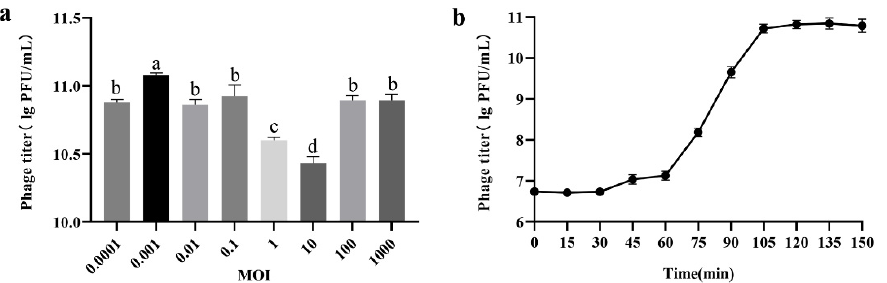
Figure 2. Biological characterization of phage PHB09. ( a ) Optimal multiplicity of infection (MOI) determination. ( b ) One-step growth curve. Values are means from three independent experiments. Means with the same letter are not significantly different from each other. Error bars indicate standard deviation.